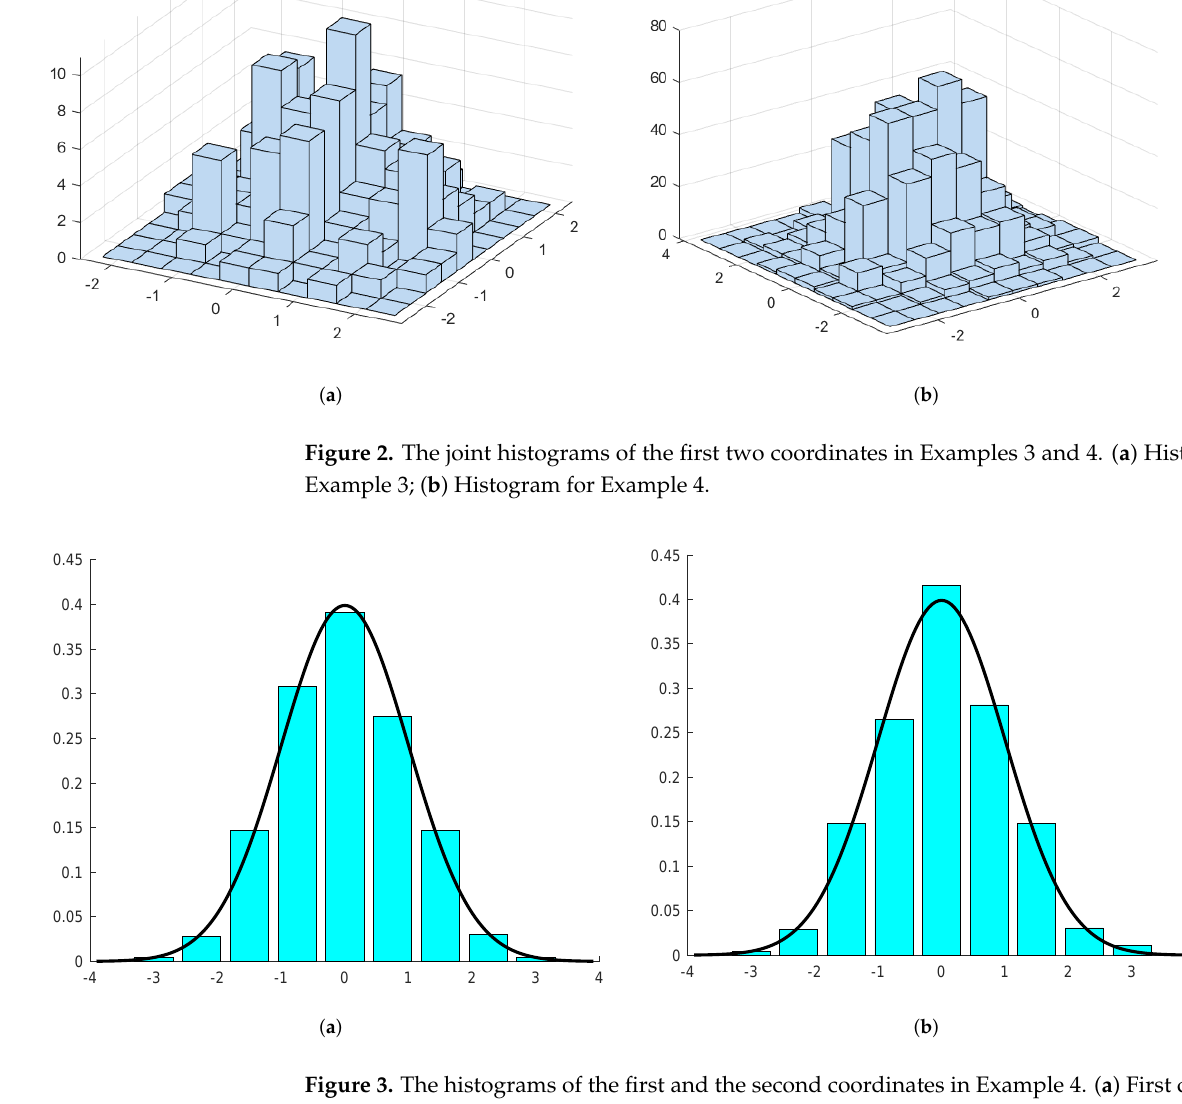
Figure 3. The histograms of the first and the second coordinates in Example 4. ( a ) First coordinate; ( b ) Second